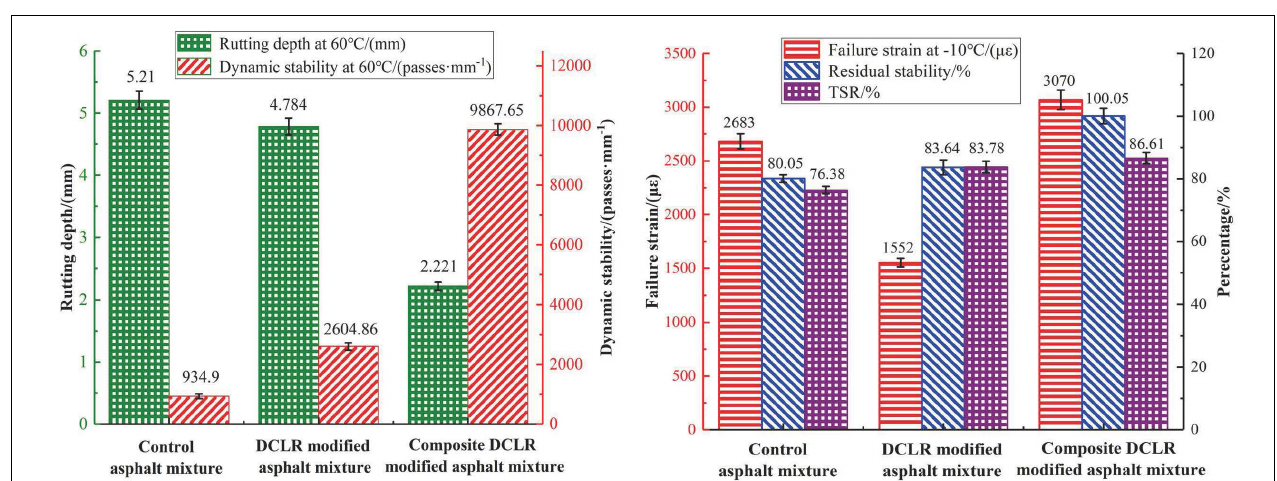
FIGURE 3 | Gradation of the mixture.